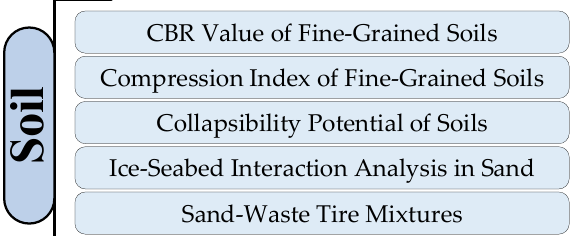
Figure 4. The studied subsections of soil.